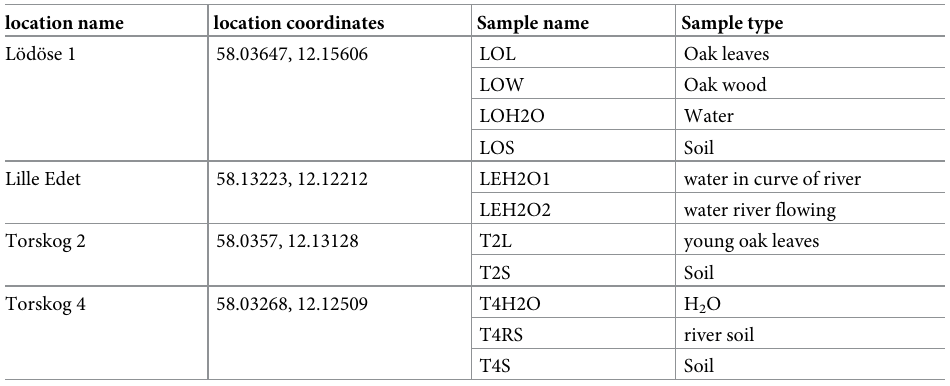
Table 2. Sample locations and description in Sweden (see also the map Fig